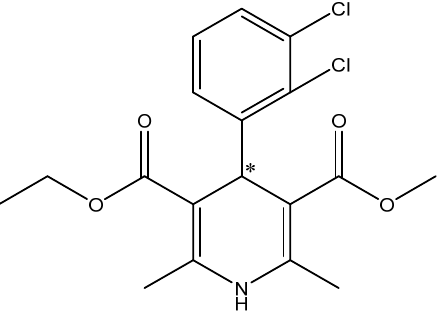
* Figure 2. Structure of racemic mixture of sotalol. Reprinted with permission from [28]; copyright